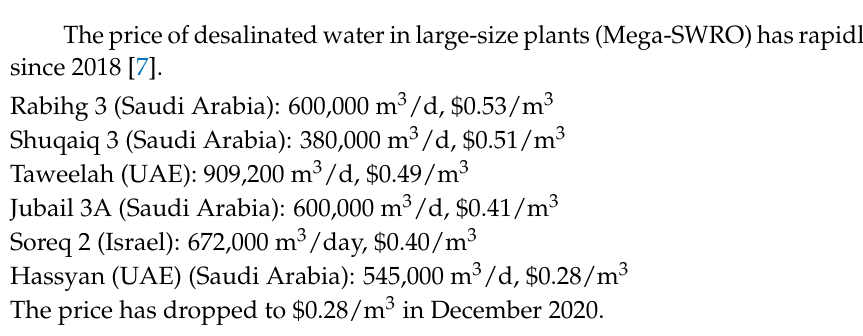
Figure 4. Rapid change of the desalinated water price since 2000